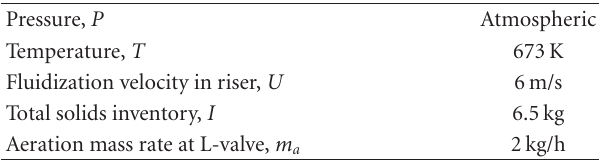
Table 2: Operational conditions of the CFB unit.